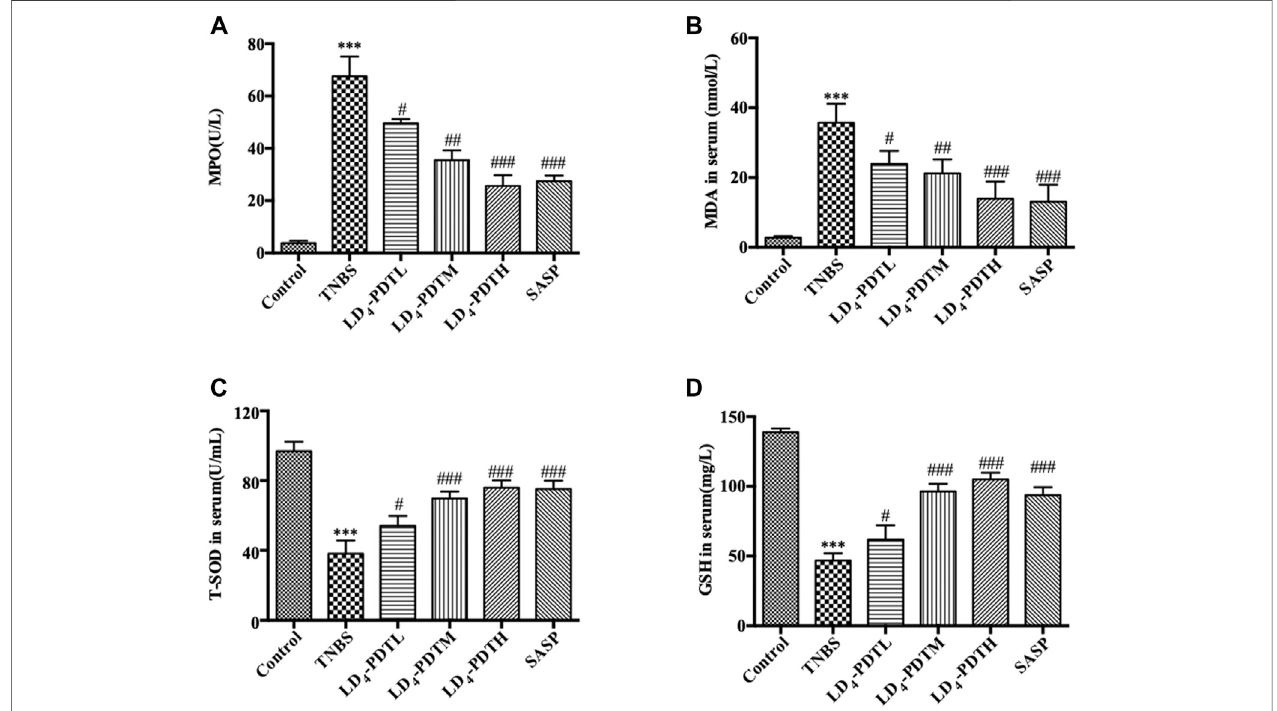
FIGURE3| LD 4 -PDT regulated oxidative stressinTNBS-induced UC model rats.Concentrations of (A) MPO , (B) MDA , (C) SOD and (D) GSH inrat ’ sserum were examined by ELISA. ** p < 0.01 , *** p < 0.001 vs control group; # p < 0.05 , ## p < 0.01 , ### p < 0.001 vs TNBS model group. n (cid:2) 10 rats per group.